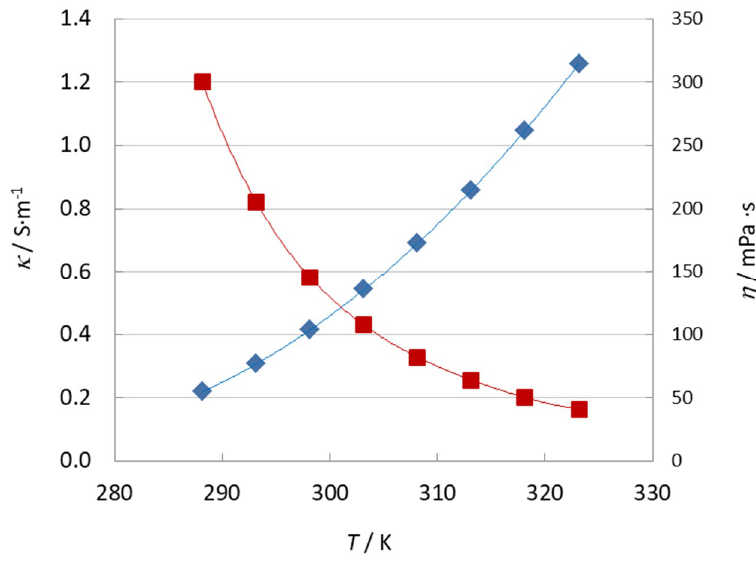
Figure 5. Electrolytic conductivity (blue squares/line) and dynamic viscosity (red squares/line) of (EMIm) 2 [Mn(NCS) 4 ] (sample I) at different temperatures T.